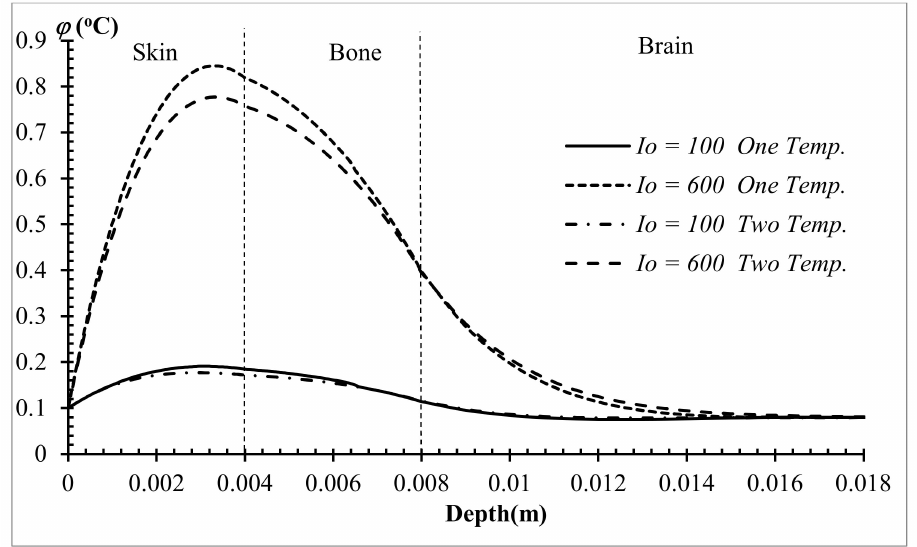
Figure 6. The conductive temperature increment with various power densities on an adult’s head.